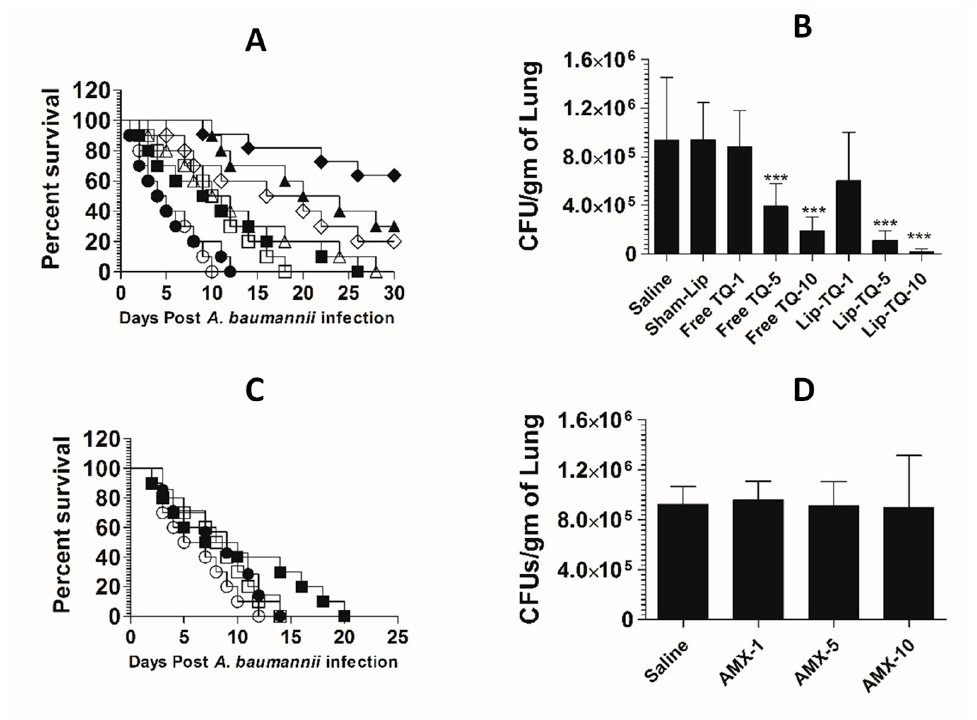
Figure 9. Treatment with Lip-TQ, not with AMX, was effective against the drug-resistant A. baumannii infection in a murine model. ( A ) Each mouse was infected with 1 × 10 7 CFUs of drug-resistant A. baumannii and treated with 1, 5 and 10 mg/kg of free TQ or Lip-TQ for seven days as described in the methodology section. The survival rate of the mice was monitored for 30 days. Saline ( ), sham-Lip ( • ), free TQ—1 mg/kg ( (cid:3) ), free TQ—5 mg/kg ( (cid:52) ), free TQ—10 mg/kg (cid:35) ( ♦ ), Lip-TQ—1 mg/kg ( (cid:4) ), Lip-TQ—5 mg/kg ( (cid:78) ), Lip-TQ—10 mg/kg ( (cid:7) ). Saline vs. free TQ—1 mg/kg ( p = 0.0051), sham-Lip vs. Lip-TQ—1 mg/kg ( p = 0.0368), free TQ—5 mg/kg vs. Lip-TQ—5 mg/kg ( p = 0.0272), free TQ—10 mg/kg vs. Lip-TQ—10 mg/kg ( p = 0.0295). ( B ) Three mice from each group were sacrificed on day 5 after thetreatment and equally weighed portions of the lung tissue were homogenized to determine the bacterial load. The data are represented as the means ± SD of three independent experiments. *** p < 0.001. ( C ) The mice infected with drug-resistant A. baumannii were treated with AMX (1, 5 and 10 mg/kg) for seven days and their survival rate was observed on day 30 post-infection. Saline ( ), AMX—1 mg/kg ( • ), AMX—5 mg/kg ( (cid:3) ), AMX—10 mg/kg ( (cid:4) ). ( D ) The bacterial load (CFUs) was determined as described in the methodology section. The data are represented as the means ± SD of three independent experiments.